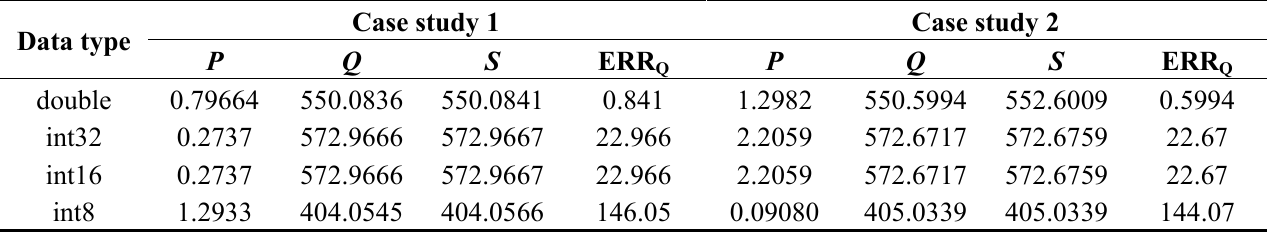
Table 5. Effect of ADC resolution on the power